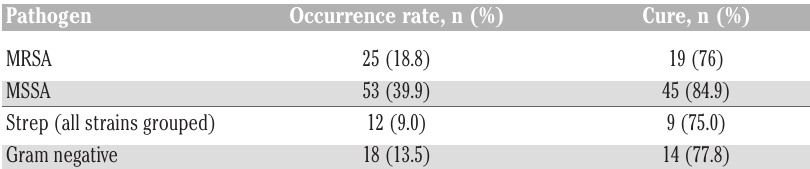
Table 4. Pathogens and cure.